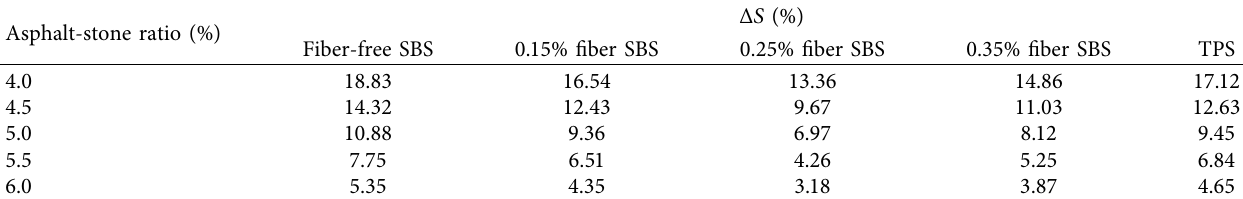
Table 9: Comparison of test results of different drainage asphalt